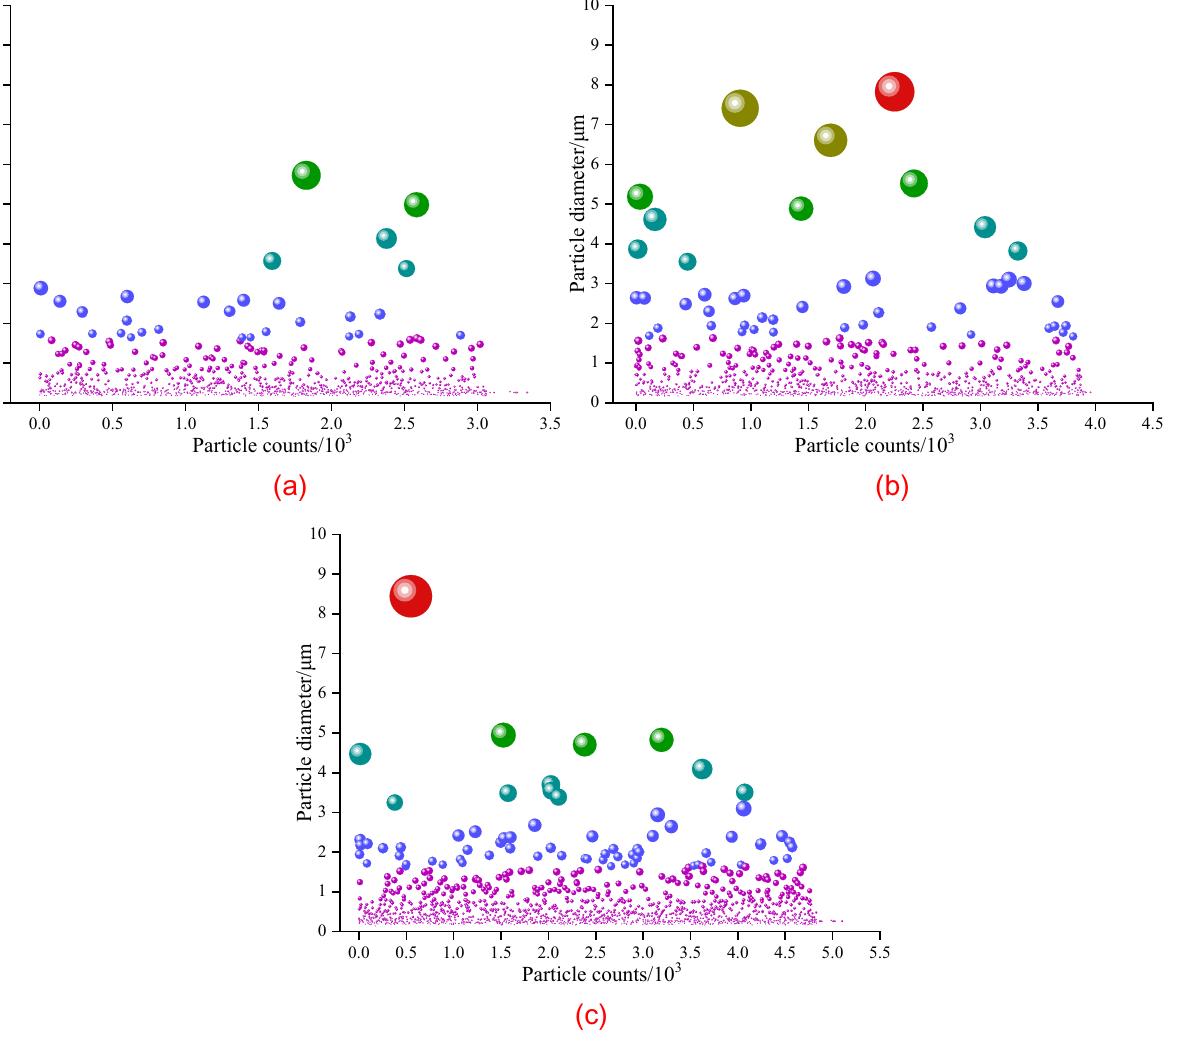
Figure 11. Statistics of the fracture particles of gypsum rocks based on the scanning electron microscopy images: ( a ) alabaster, ( b ) transparent gypsum, and ( c ) ordinary gypsum. The size of the ball is consistent with the diameter of the fracture